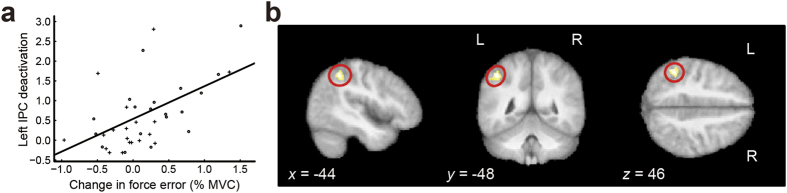
fMRI results of parametric analyses.(a) Individual changes in force error were positively and significantly related to the decrease in parameter estimates of the left IPC cluster from the unobserved to observed condition. The pluses denote the 5% MVC task and the circles the 10% MVC task. (b) The left IPC showed both deactivation in proportion to the socially-induced increase in force production and decreased functional connectivity with the right pSTS during social evaluation. Clusters are illustrated at p < 0.001.